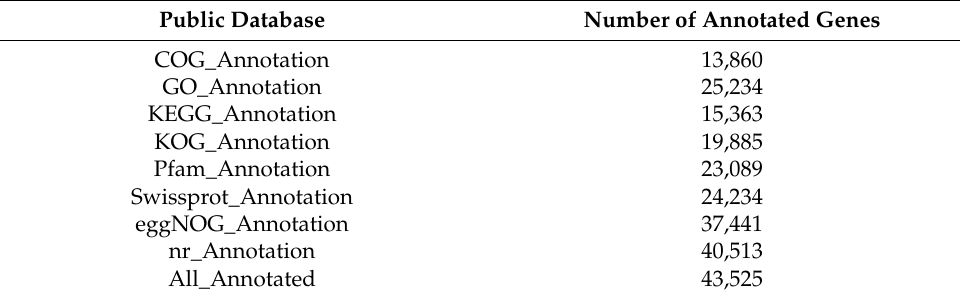
Table 2. Numbers of unigenes annotated in eight databases.